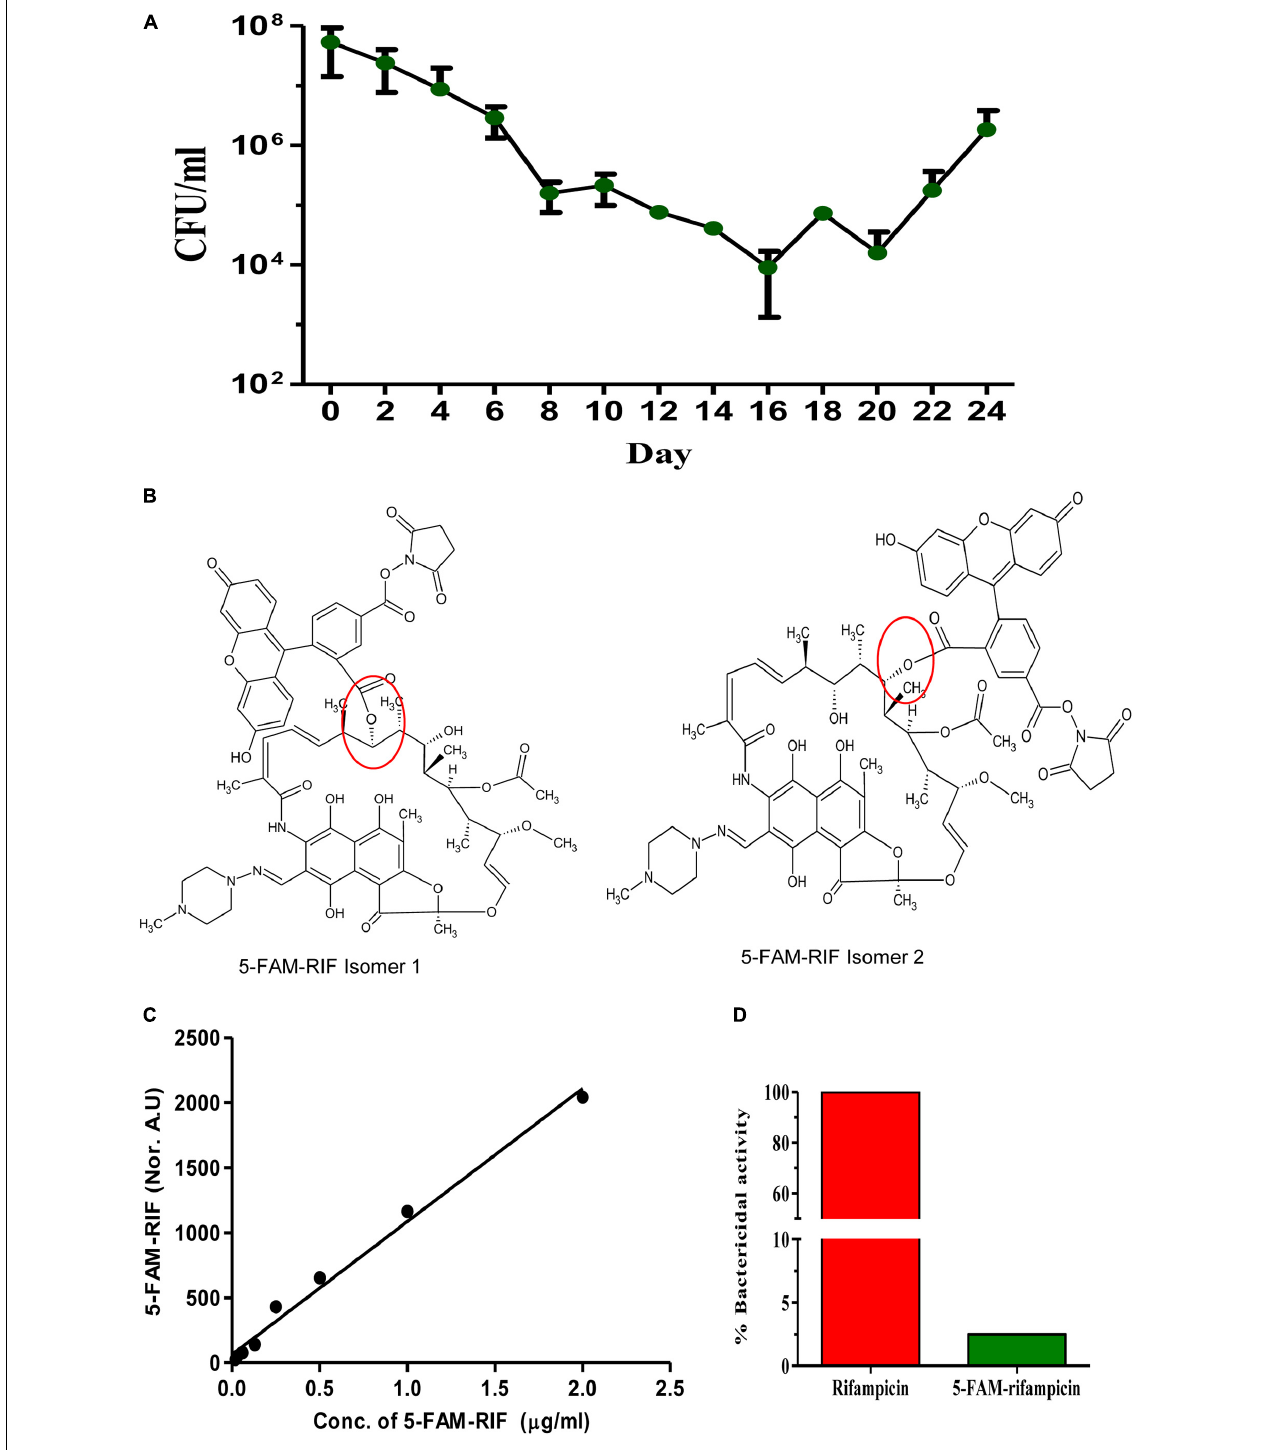
FIGURE 1 | Triphasic response of Mtb culture to rifampicin and validation of 5-FAM-rifampicin as a permeability probe for rifampicin. (A) Triphasic response of Mtb culture to 10 × MBC rifampicin. (B) The possible structural isomers of 5-FAM-rifampicin conjugates. The carboxyl group of the 5-FAM can form an ester bond with any one of the hydroxyl groups in the aliphatic ring of rifampicin, generating two possible isomers. Ester bond is shown in red circle. This structure of 5-FAM-rifampicin is a modified version of the independent structures of the rifampicin and 5-FAM shown in the Supplementary Figures S3A,B in Jakkala and Ajitkumar (2019). (C) Standard graph showing the 5-FAM-rifampicin permeability into MLP cells at two-fold increasing concentrations. (D) Bar graph showing the growth inhibition of Staphylococcus aureus by rifampicin and 5-FAM-rifampicin using agar diffusion assay.